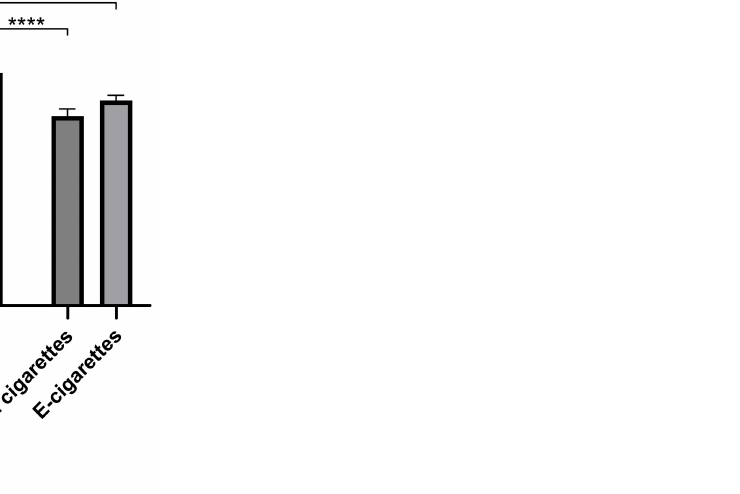
Figure 5. Values of TAOS (total antioxidant status) in groups of e-cigarettes users, traditional cigarettes smokers and non-smokers. *** p < 0.001; **** p < 0.0001. The value of TEAC in the group of e-cigarettes users was 1.3 mM (0.04), in the group of traditional cigarettes users was 1.2 mM (0.05) and among non-smokers was 1.5 mM